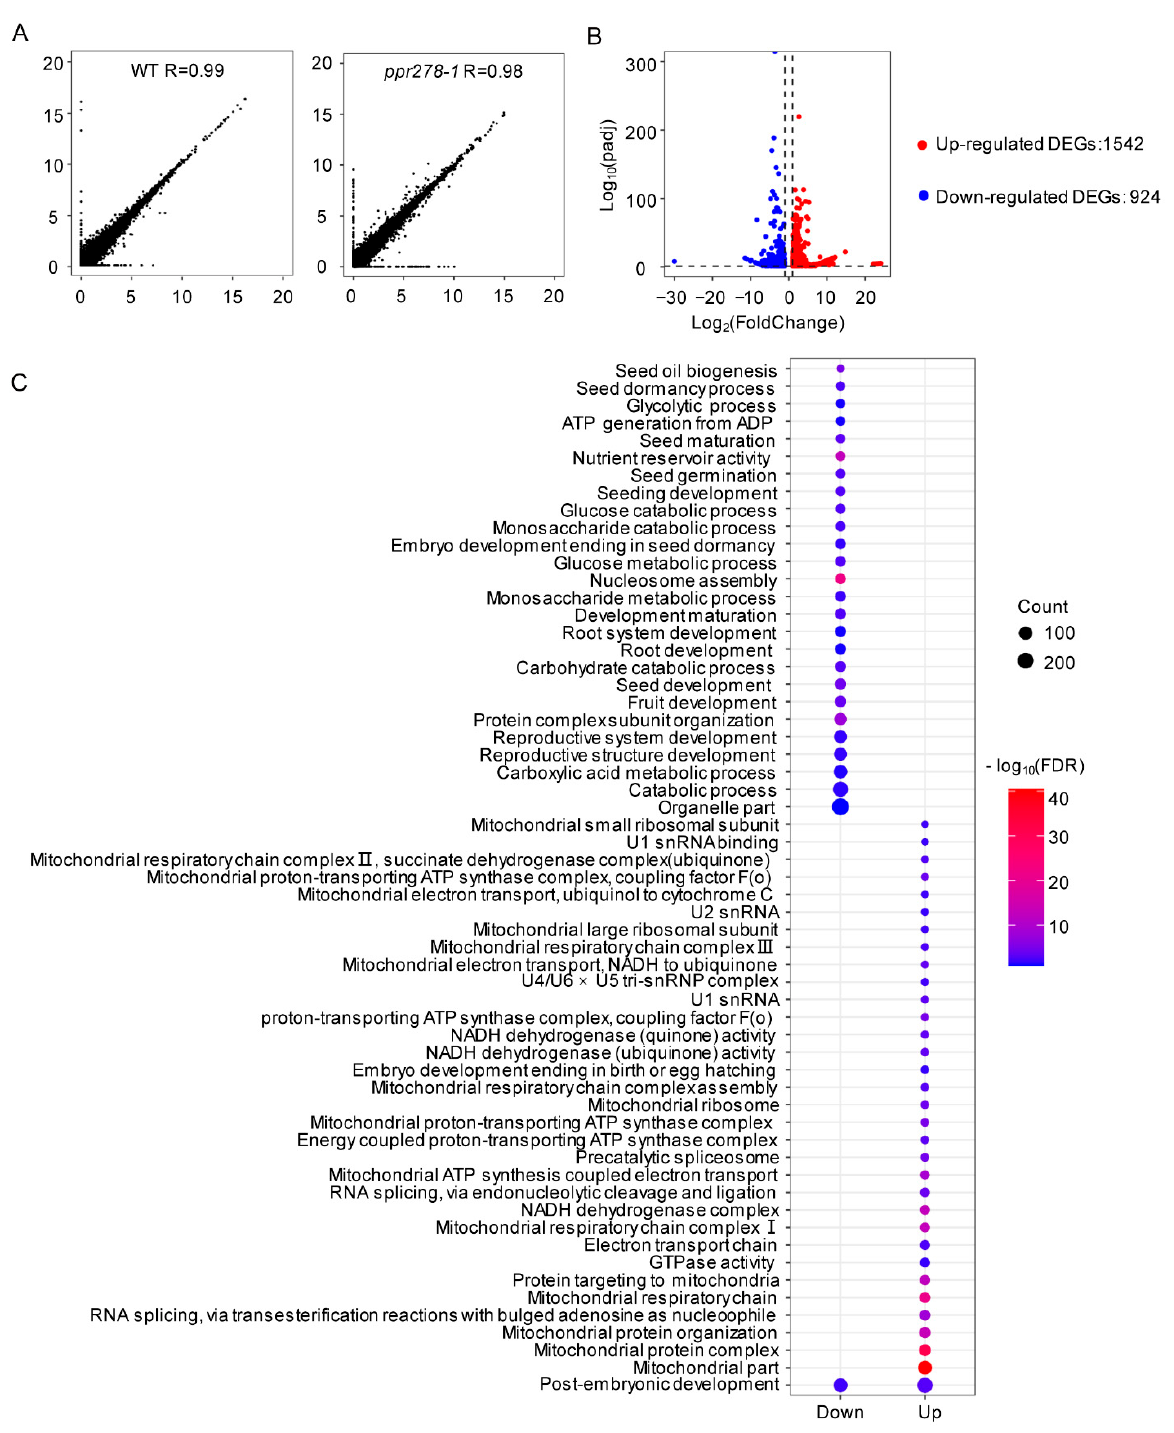
Figure 6. Transcriptome analysis in the ppr278-1 mutant. ( A ) Correlation between the replicates of RNA-seq data in WT and ppr278-1 plants. The x- and y-axes represent replicate 1 and replicate 2, respectively. ( B ) Volcano plot displaying differentially expressed genes (DEGs) between WT and ppr278-1 plants. The y -axis corresponds to the mean expression value of log10 ( p -value), and the x -axis displays the log2 (fold change) value. Red dots represent the up-regulated transcripts between WT and ppr278-1 plants. Blue dots represent the down-regulated transcripts. ( C ) GO terms of the top 33 and 27 up- and down-regulated DEGs, respectively, in WT and ppr278-1 plants. The size of the dot represents the number of genes. The color shows the value of − Log10 (FDR, false discovery rate).